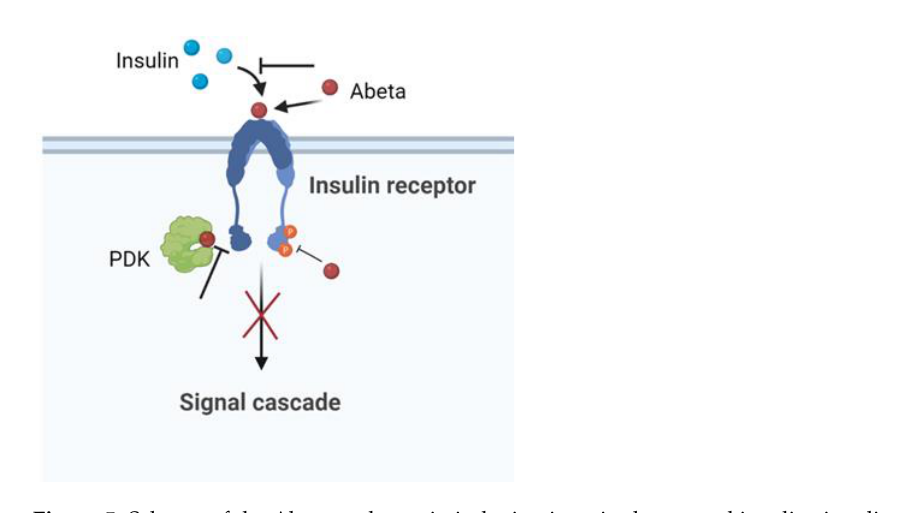
Figure 5. Scheme of the Abeta pathway in inducing impaired neuronal insulin